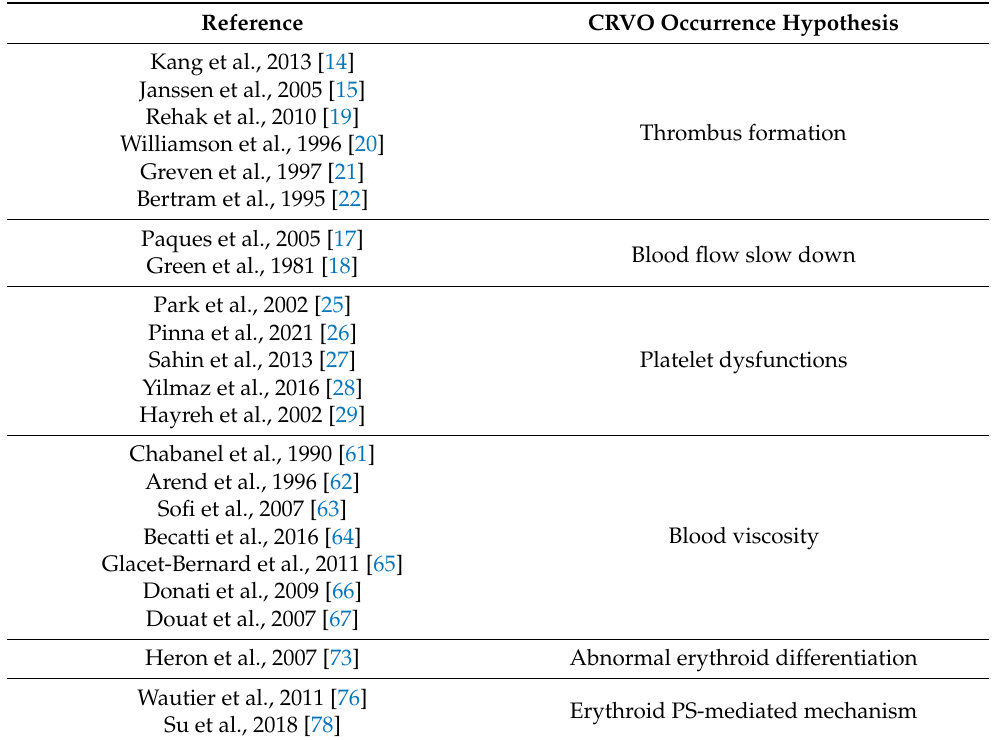
Table 1. Main hypothesis on CRVO